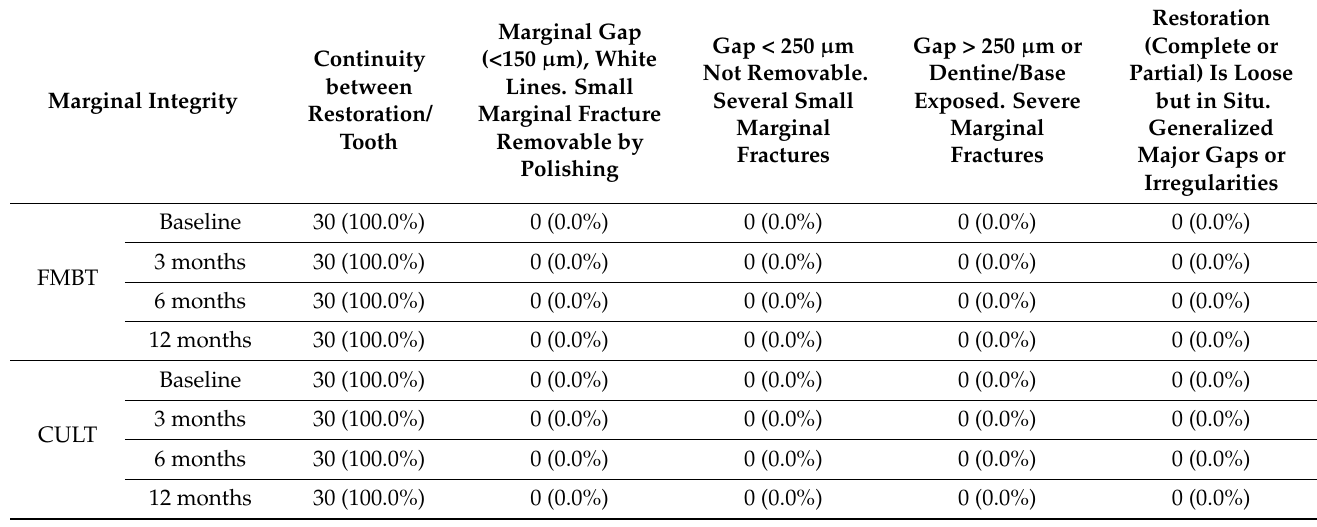
Table 6. Assessment of marginal integrity of restored teeth with FMBT and CULT over time ( p > 0.05).